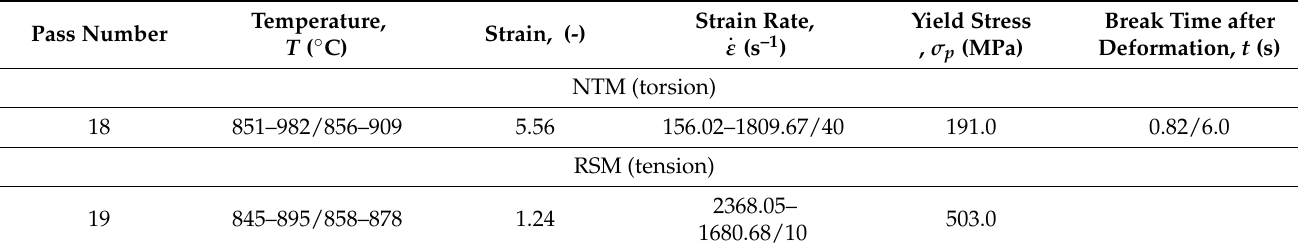
Table 5. Parameters of the deformation process during physical modelling of rolling a 20MnB4 steel wire rod with a diameter of 5.5 mm in NTM and RSM blocks of a wire rod rolling mill (test variant V3) [17,21].